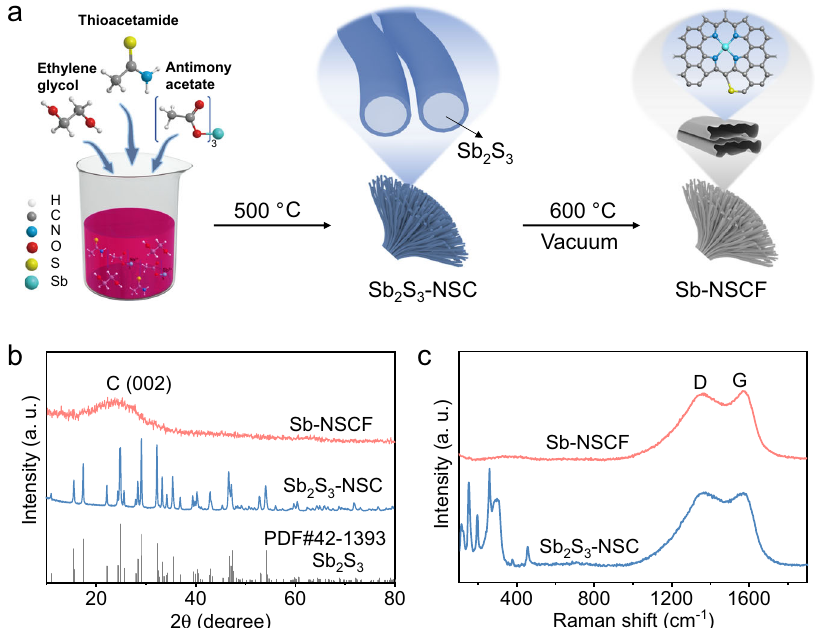
Fig. 1 | Synthesis and characterizations of Sb-NSCF. a Schematic illustration of the preparation of Sb-NSCF. b XRD patterns of Sb-NSCF, Sb 2 S 3 -NSC, and the Sb 2 S 3 standard. c Raman spectra of Sb-NSCF and Sb 2 S 3 -NSC.